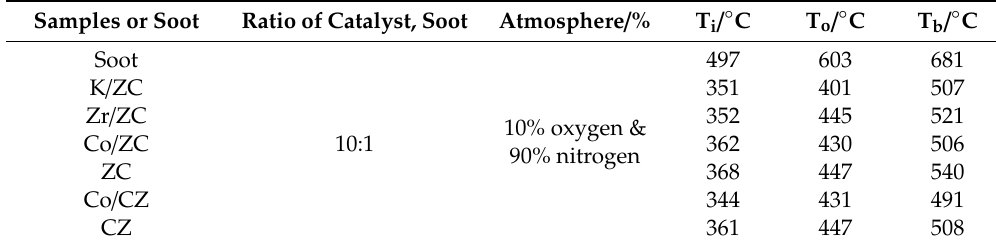
Table 1. The soot combustion parameters with catalysts (data from TG-DSC). Samples or Soot